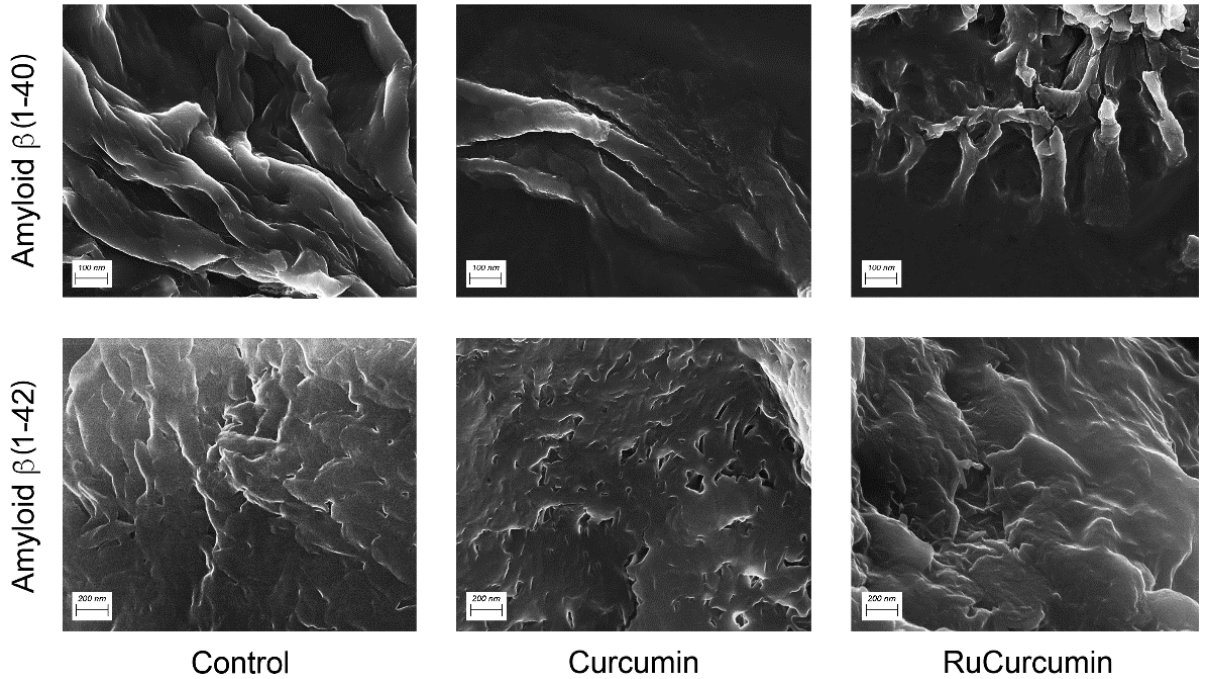
Figure 5. SEM analysis of amyloid aggregates. Comparison of the morphology of A β (1–40) and A β (1–42) fibril aggregates in the absence and in the presence of 20 µ M curcumin and RuCurcumin.